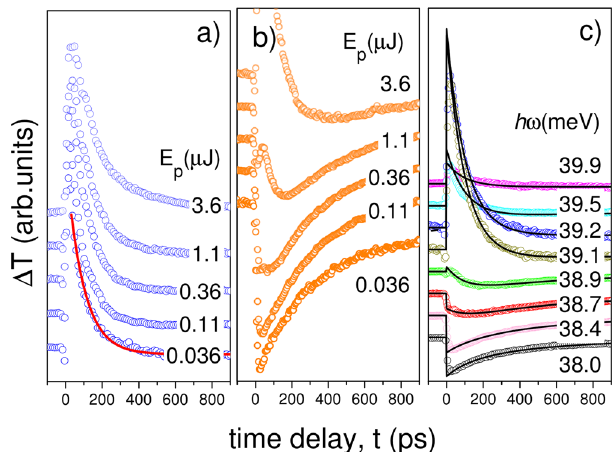
Fig. 2 Pump-probe transients on or near the 1 s – 2 p ± transition for different laser intensities. The transient transmission change of the probe due to the pump pulse, Δ T is shown vs. t . They have been normalized to their global maximum and offset vertically. a Pump pulse energy ( E p ) dependence on resonance (at laser photon energy ħ ω = 39.2 meV) for nat Si:P. The solid line is an exponential decay fi t. b As in a but off-resonance at ħ ω = 38.6 meV. c Dependence of the transients on photon energy ( ħ ω ) at a fi xed pulse energy of E p = 0.11 μ J. The solid lines are fi ts with Eq. (3) as described in the text.